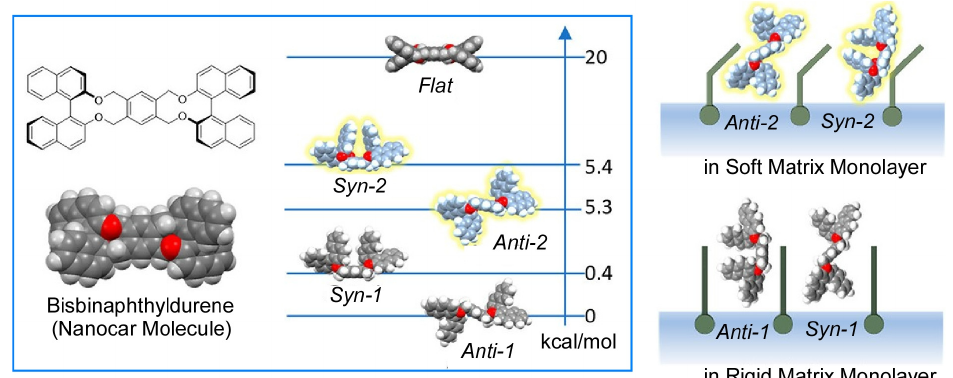
Figure 22. Behavior of bisbinaphthyldurene molecules (considered as nanocar molecules on a solid surface) at the air-water interface. Reprinted with permission from Reference [194]. Copyright 2020 American Chemical Society.